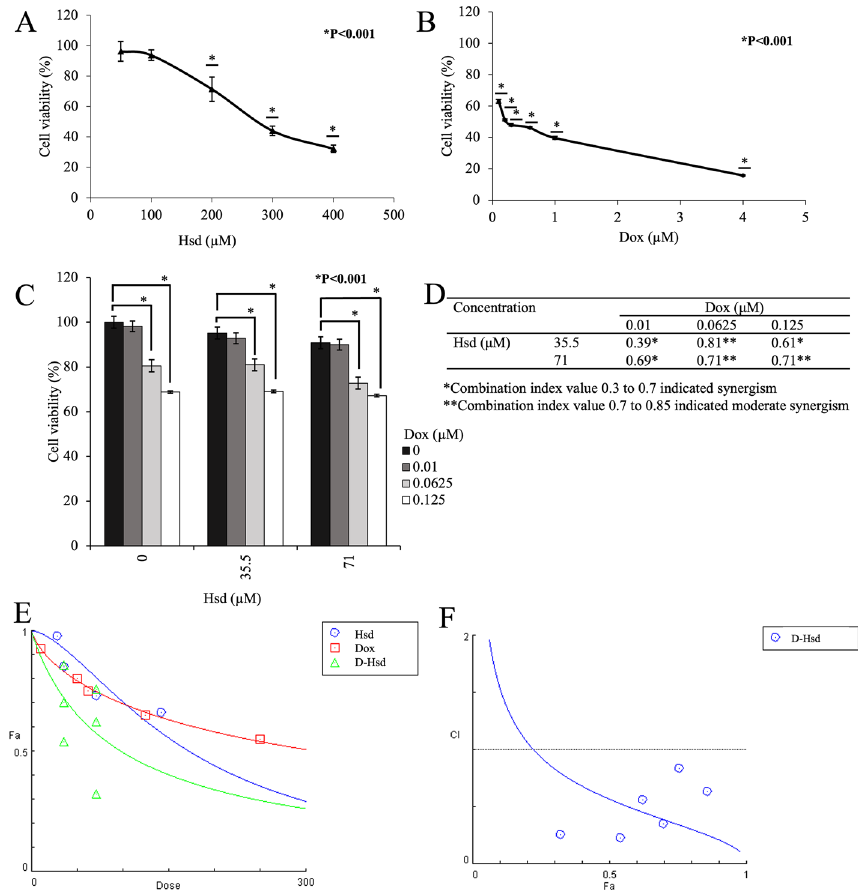
Fig. 1 Synergism cytotoxicity of Hsd and DOX on 4T1 breast cancer cells. 4T1 cells were treated individually or in combination with Hsd plus DOX at various concentrations for 24 h, and the viability of cells was evaluated using MTT assay. Percentage of cell viability under A Hsd and B DOX, C combination of Hsd-DOX treatment for 24 h. Cell viability profiles were expressed as mean combination index (CI) value of various combination ratios. CI value below and above CI E Dose–effect curves of Hsd, DOX, and its combination. Dose–effect curves were generated from the CompuSyn calculation, and the values are the mean of three experiments. F Combination index plot among 6 combinations, all of the data were on the synergistic side (CI < 1). * p < 0.001 (post-hoc LSD test between each group) was considered statistically